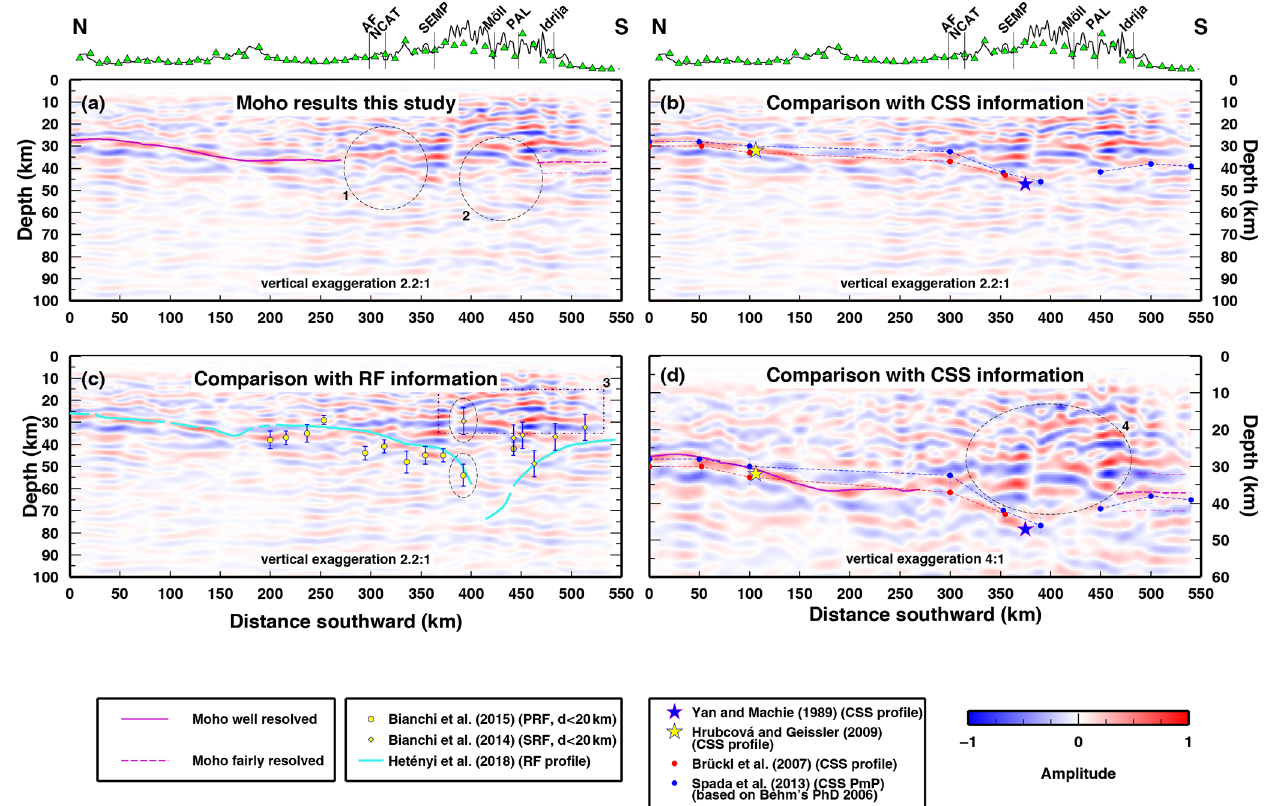
Figure 5. Reflectivity images of the crust and upper mantle along EASI; in the background the interpolated figure as in Fig. 4b. (a) Moho topography beneath the northern Alpine Foreland and the Alps as detailed by results of this study. The subhorizontal and gently dipping Moho is well imaged by our global-phase interferometry, but the typical Moho signal disappears beneath the central parts of the Eastern Alps (features 1 and 2). (b) Comparison with CSS information documenting the generally good correlation between our new Moho results and previous information on crustal thickness outside the Alps. (c) Comparison with RF information where we evidence the co-location of the high reflectivity of crust and the detected anisotropic layer (feature 3). (d) Comparison with CSS information in an enlarged version allows highlighting more detail, and it reveals a nearly perfect correspondence with the PmP model (Behm, 2006; Spada et al., 2013) in the north and an equally good correspondence with the refraction seismic model (Brückl et al., 2007) in the southern part of the foreland. The strong reverberation directly beneath the Alps (4) documents the complex internal crustal structure of the